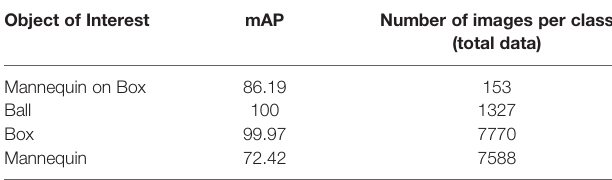
TABLE 2 | The average precision for different